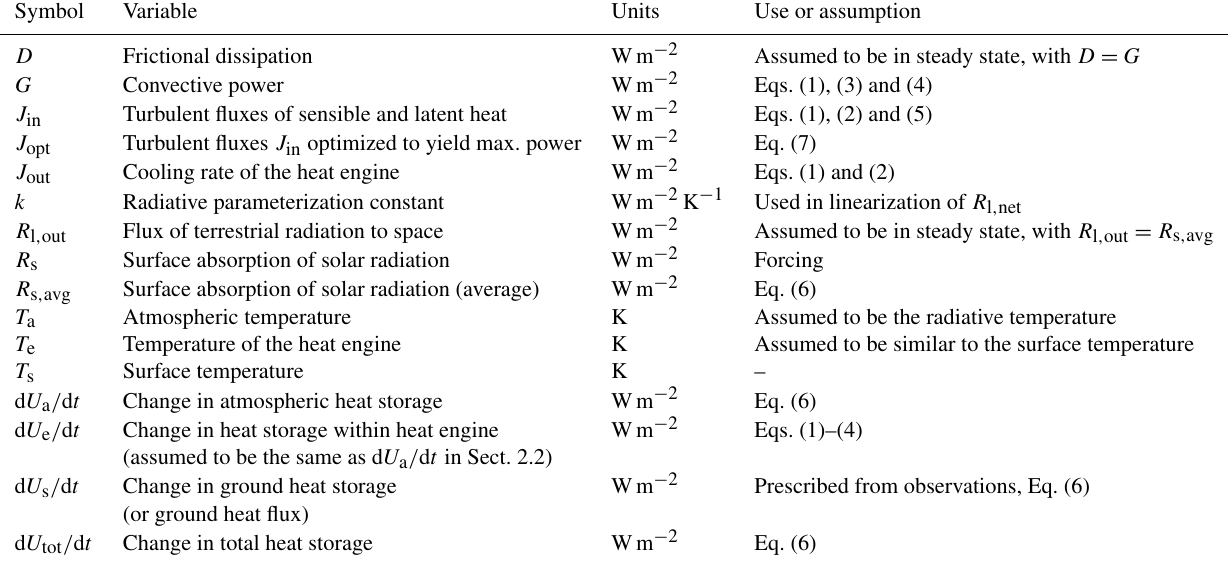
Table 1. Variables and parameters used in this study. Symbol Variable Units Use or assumption D Frictional dissipation